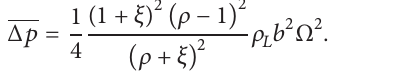
angle body oscillations reaches the value of 1.2 degrees, which is several times higher than in case of the body 𝜌 =